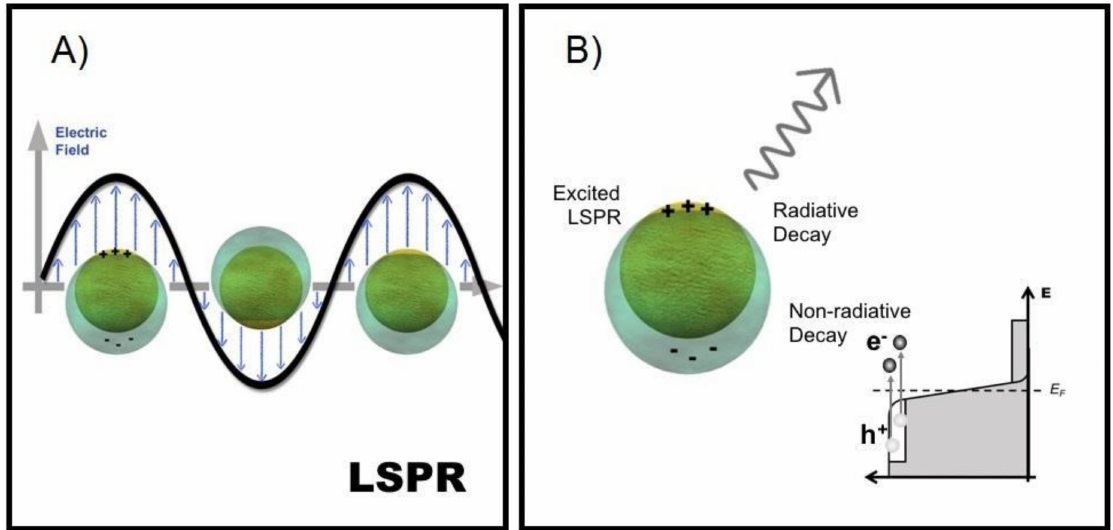
Figure 2. ( A ) Schematic representation of the Localized Surface Plasmon Resonance condition in Plasmonic NPs; ( B ) Once excited the LSPRs of Plasmonic NPs, it will decay either radiatively through the re-emission of a photon or non-radiatively by the generation of hot electron-hole pairs in the